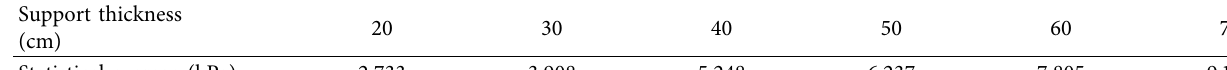
Figure 7: Distribution characteristics of surrounding rock pressure of support structure with diferent thicknesses after full-face Table 5: Statistical average value of surrounding rock pressure in full-face excavation.